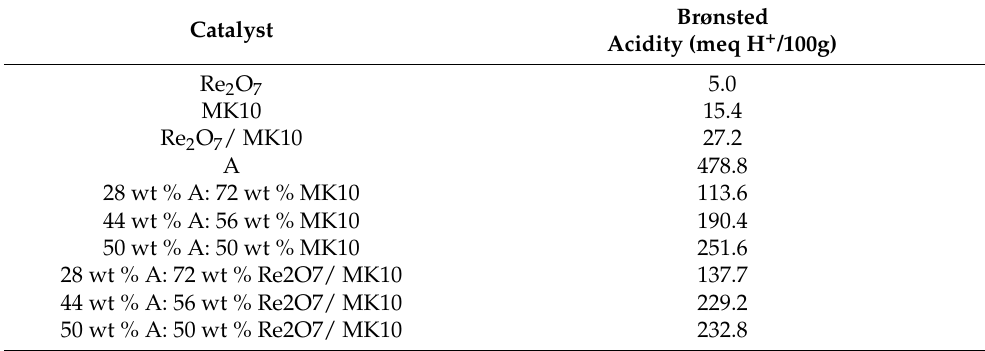
Table 4. Characterization of the Brønsted acidity of the physical mixtures and starting compounds.